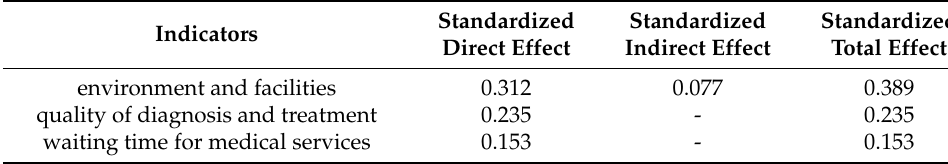
Table 3. Effects of the factors on the outpatient satisfaction based on SEM 1 .